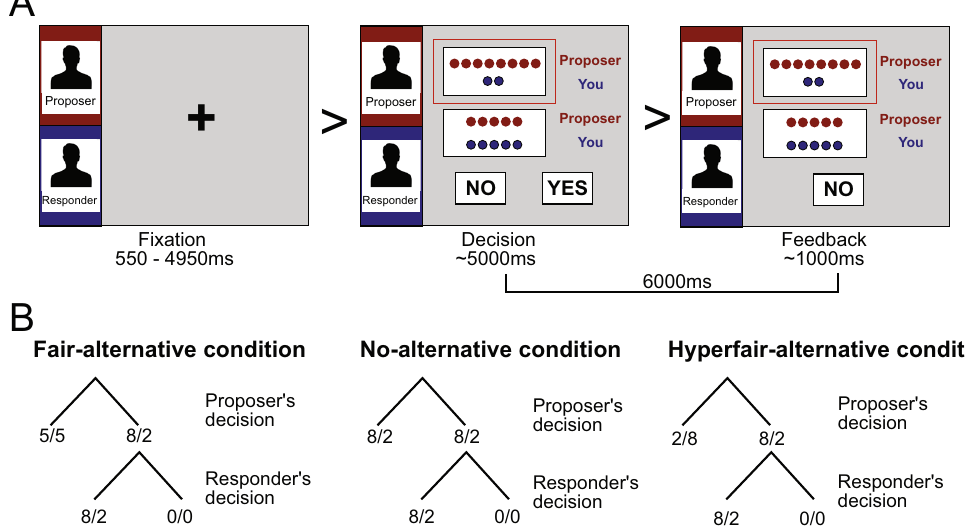
Figure 1. Experimental design. ( A ) An illustration of a single trial of the UG task (fair-alternative condition). Each trial started with the presentation of a fixation crosshair with a jittered inter-stimulus interval (mean = 1530 s, min = 550 ms, max = 4950 ms; optimized with Opt-Seq 2; surfer.nmr.mgh.harvard.edu/ optseq; 68 , followed by a decision phase where the participants made decisions after viewing two options available to the proposer and the proposer’s decision. The participants were instructed to make a decision within 5000 ms and their choice was shown on the feedback screen until the end of 6000 ms. ( B ) Examples of decision trees for the fair-alternative, no-alternative, and hyperfair-alternative